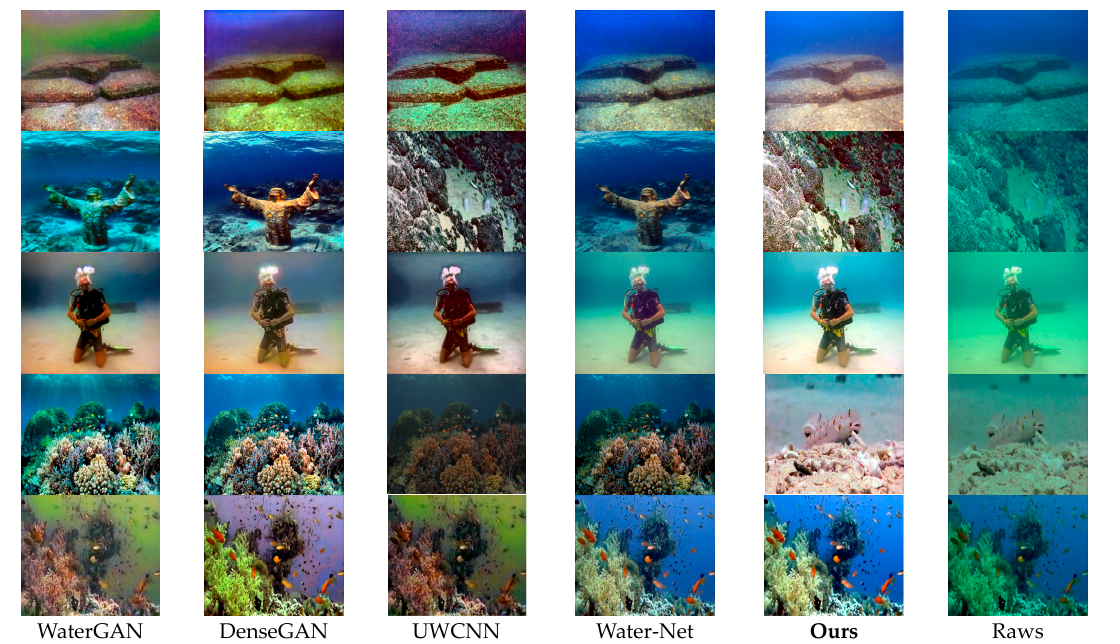
Figure 8. Comparison with deep learning methods.